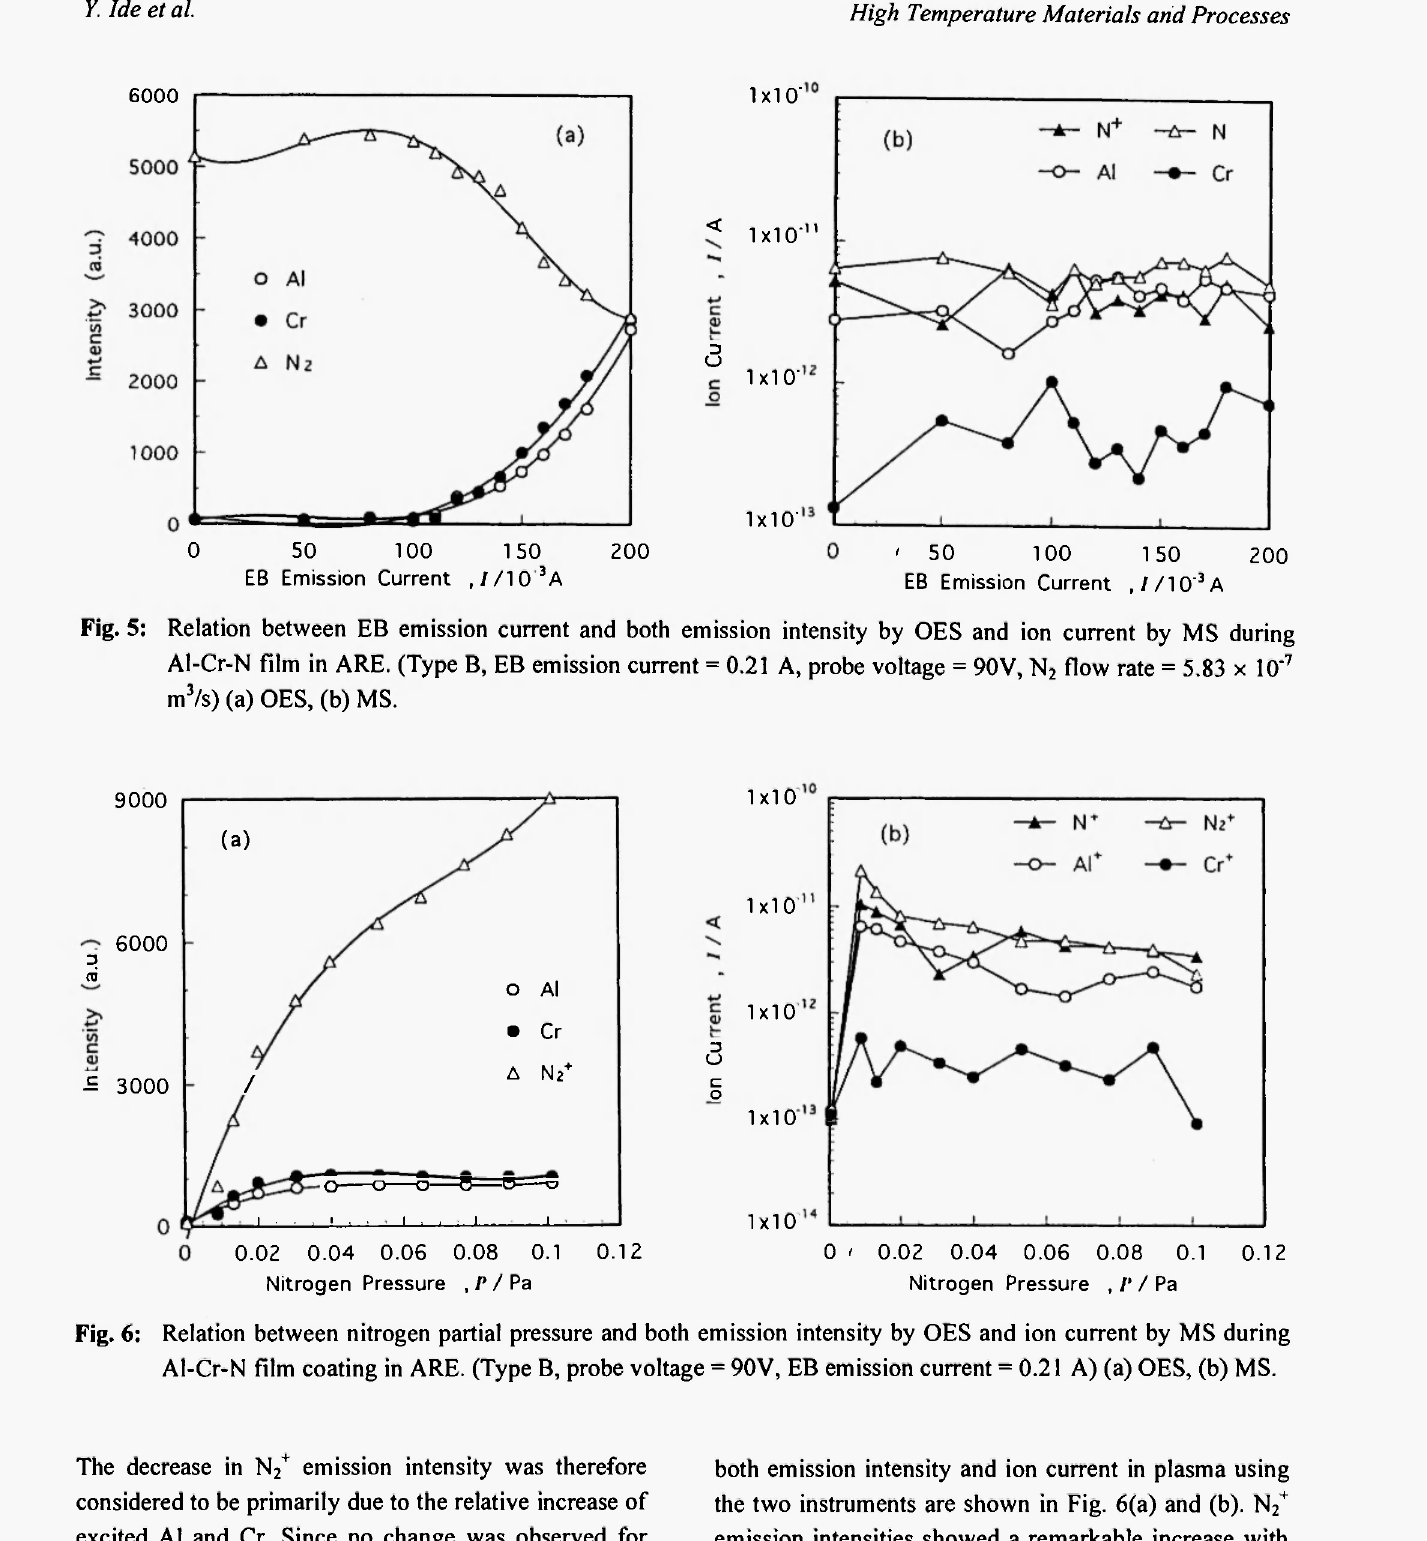
The decrease in N 2+ emission intensity was therefore considered to be primarily due to the relative increase of excited Al and Cr. Since no change was observed for ion current with change in EB emission current shown in (b), the ionization of Al, Cr and nitrogen was not affected by this